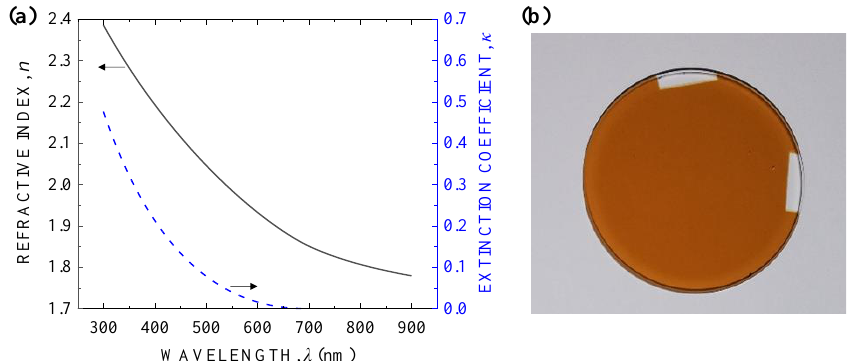
Figure 1. ( a ) Refractive index n (black solid line) and extinction coefficient κ (blue dashed line) of the silicon suboxide film measured as a function of the wavelength λ . ( b ) Photograph of the film on a fused silica substrate 25 mm in diameter.